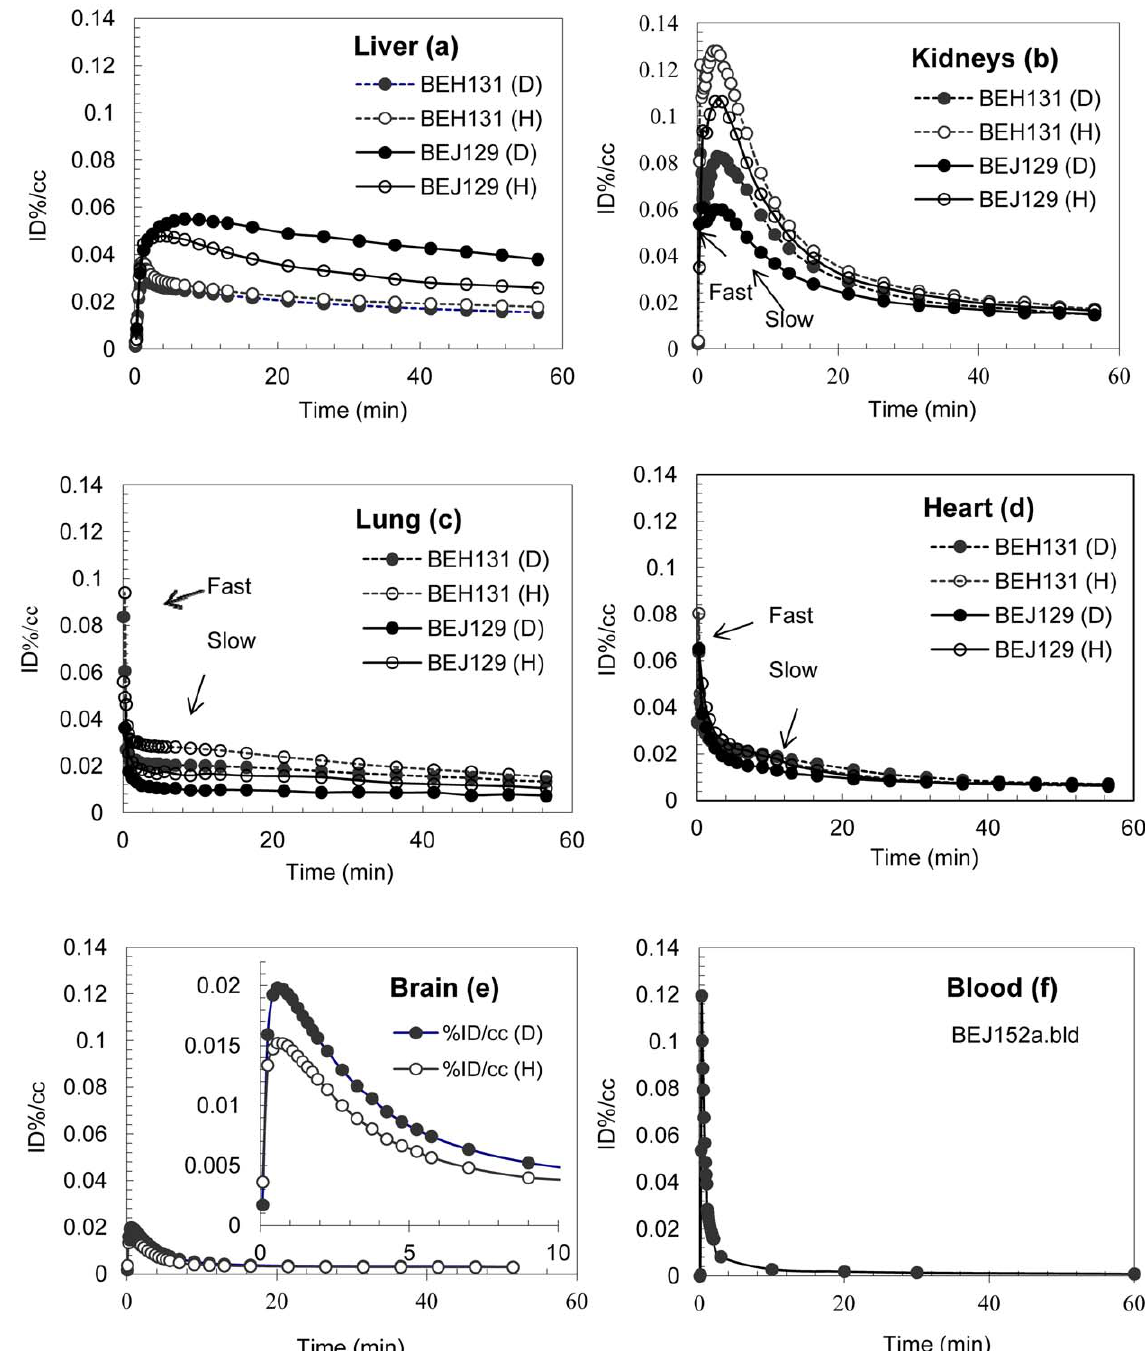
Figure 2. Time activity curves in liver (TAC) (a); kidney (b); lung (c); heart (d) in baboons (April: BEJ129 and Missy: BEH131) and Brain (e) and blood (f) in baboon (Pearl: BEJ152a) of tracers 1 (H) and 2 (D). doi:10.1371/journal.pone.0046676.g002 isotope effect. A total of nine studies were conducted, six with 1 and three with 2 . Alcohol was distributed in most of the brain regions, but showed higher concentration in striatum (C max = 0.028% ID . mL 2 1 ) and cerebellum (C max = 0.026% ID . mL 2 1 ) for 1 and in striatum (C max = 0.034% ID . mL 2 1 ), cingulate (C max = 0.033% ID . mL 2 1 ), cerebellum (C max = 0.031%